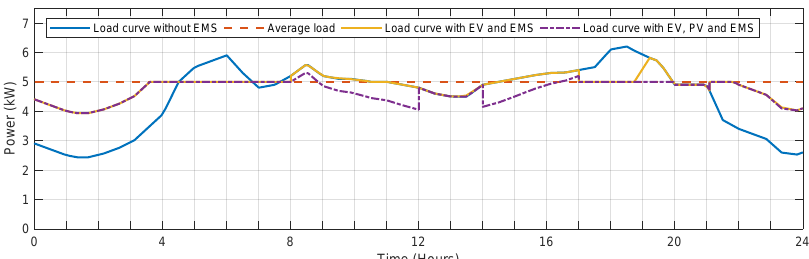
Figure 12. Daily household Power load curve without EMS, daily household Power load curve with EV and EMS, and daily household Power load curve with EV, PV, and EMS.